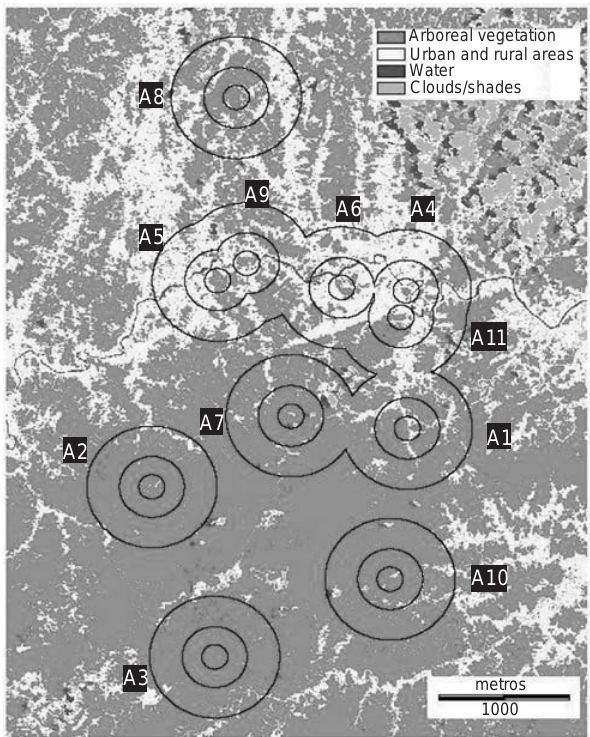
Figure 1. Atlantic Forest remnants of the hydrographic bacin of the Itajaí River, Santa Catarina, surveyed in this study. The circles indicate area buffers. The image was made available by the Instituto de Pesquisas